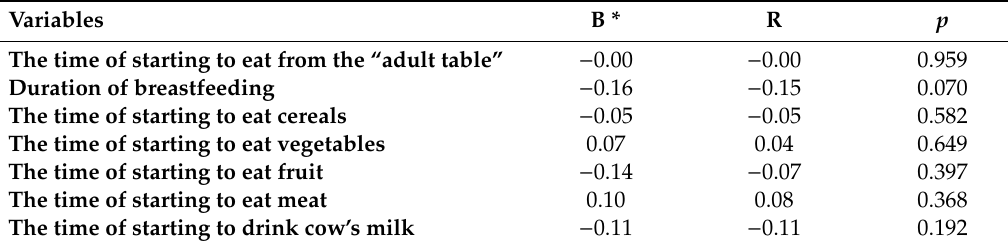
Table 4. Assessment of the largest and the smallest impact of the time of introducing individual products and duration of breastfeeding on the children’s BMI percentile.